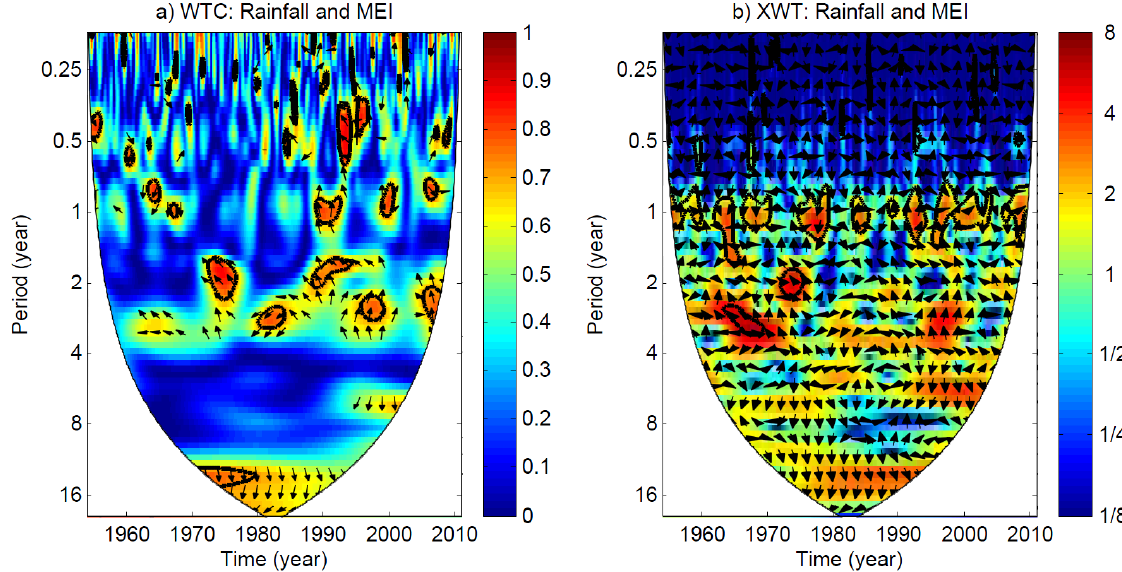
Figure 5. Wavelet coherency ( a ) and cross-wavelet spectrum ( b ) analysis showing the relations between Huangfuchuan rainfall and MEI. The thick black contour indicates the 95% confidence level against red noise and the cone of influence is shown as the lighter shade. The arrows (vectors) designate the phase difference between Huangfuchuan rainfall and MEI (with in-phase pointing right, anti-phase pointing